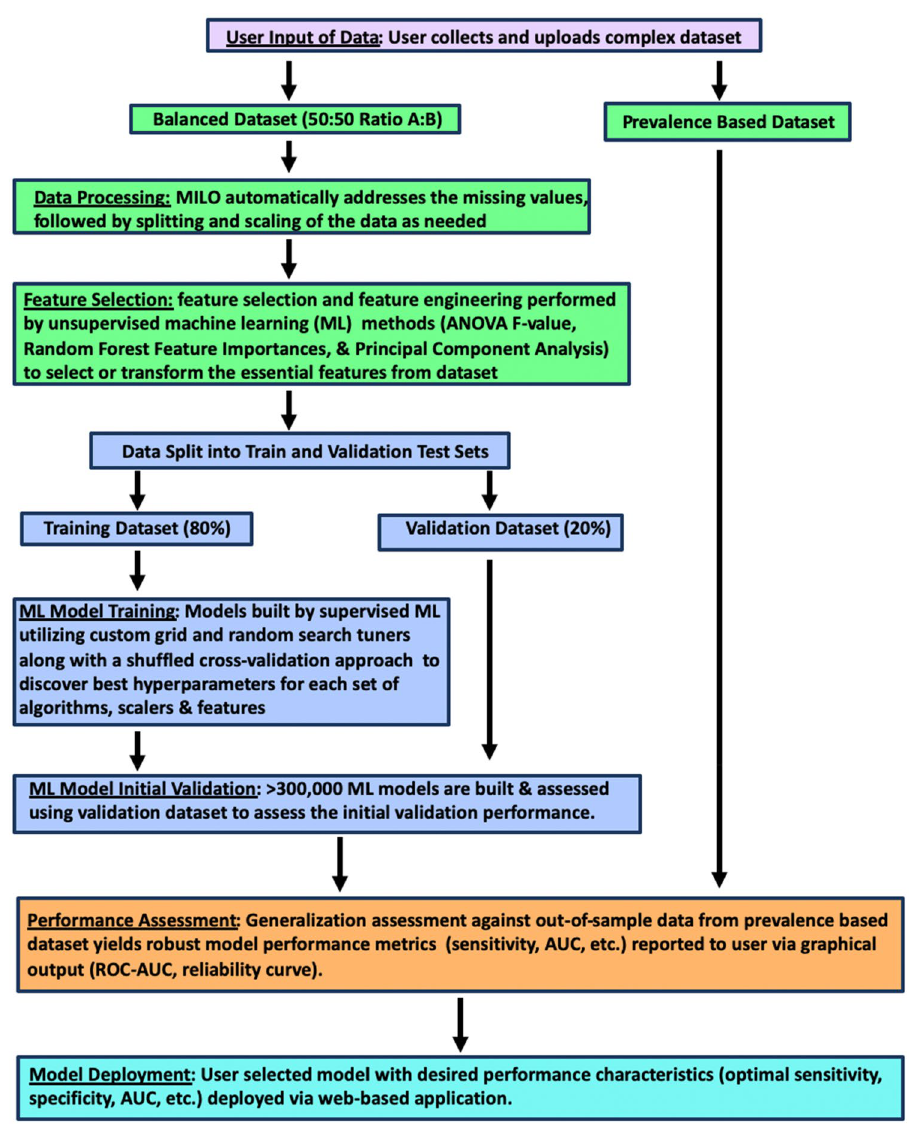
Figure 1. Schematic of the automated-machine learning platform MILO. Overview of the infrastructure and process for data processing, feature selection, and subsequent model training, building, initial validation, generalization testing and selection. MFI values for 31 anti- M.tb. antigens generated by multiplex microbead immunoassays comprise the balanced training dataset (Dataset A in this study). A large number of optimized models (> 300,000) were generated from the training dataset after data processing, feature selection, training, and validation. The true performance of the optimized models is then evaluated on the out-of-sample generalization (ideally prevalence-based) dataset (Datasets B and C in this